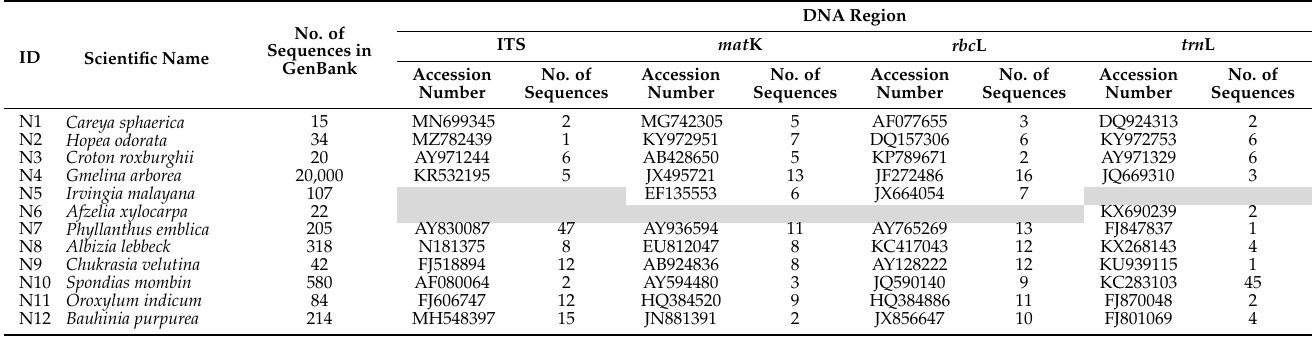
Table 3. Details of sequences retrieved from